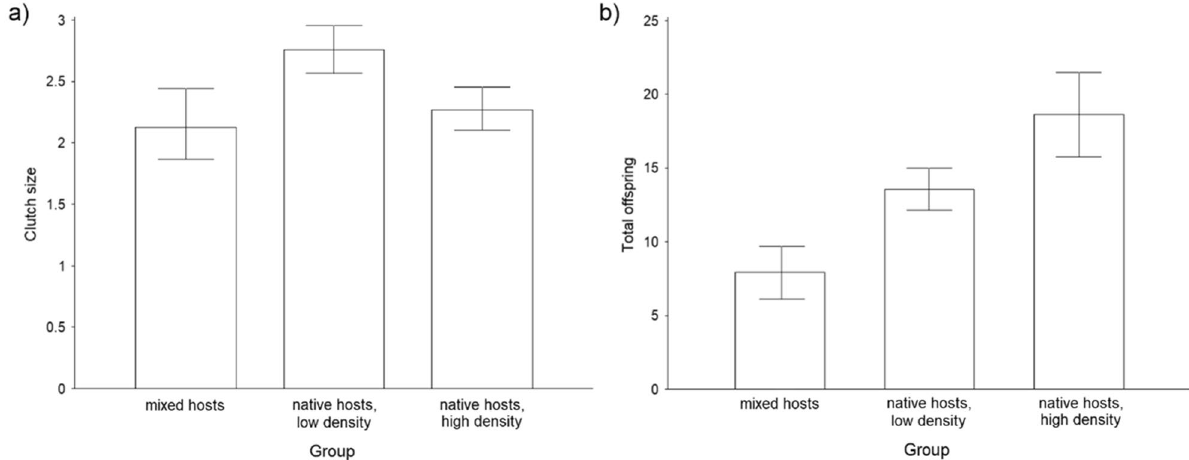
Figure 3. ( a ) Clutch size (i.e. offspring per parasitised host egg) and ( b ) total number of offspring per female A. flavipes under different conditions: mixed hosts (6 native host eggs and 6 non-native host eggs), native host, low host density (6 native host eggs); native host, high population density (12 non-native host eggs). Mean values and 95% confidence